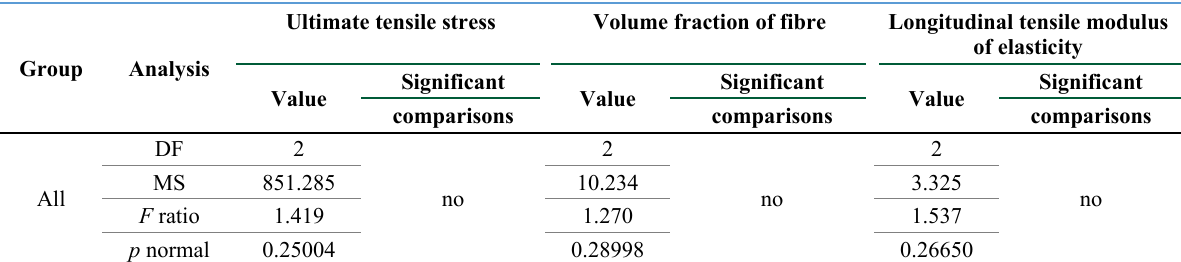
Table 7. ANOVA for evaluation of statistically significant differences in the characteristics of the composite plates from different production groups.